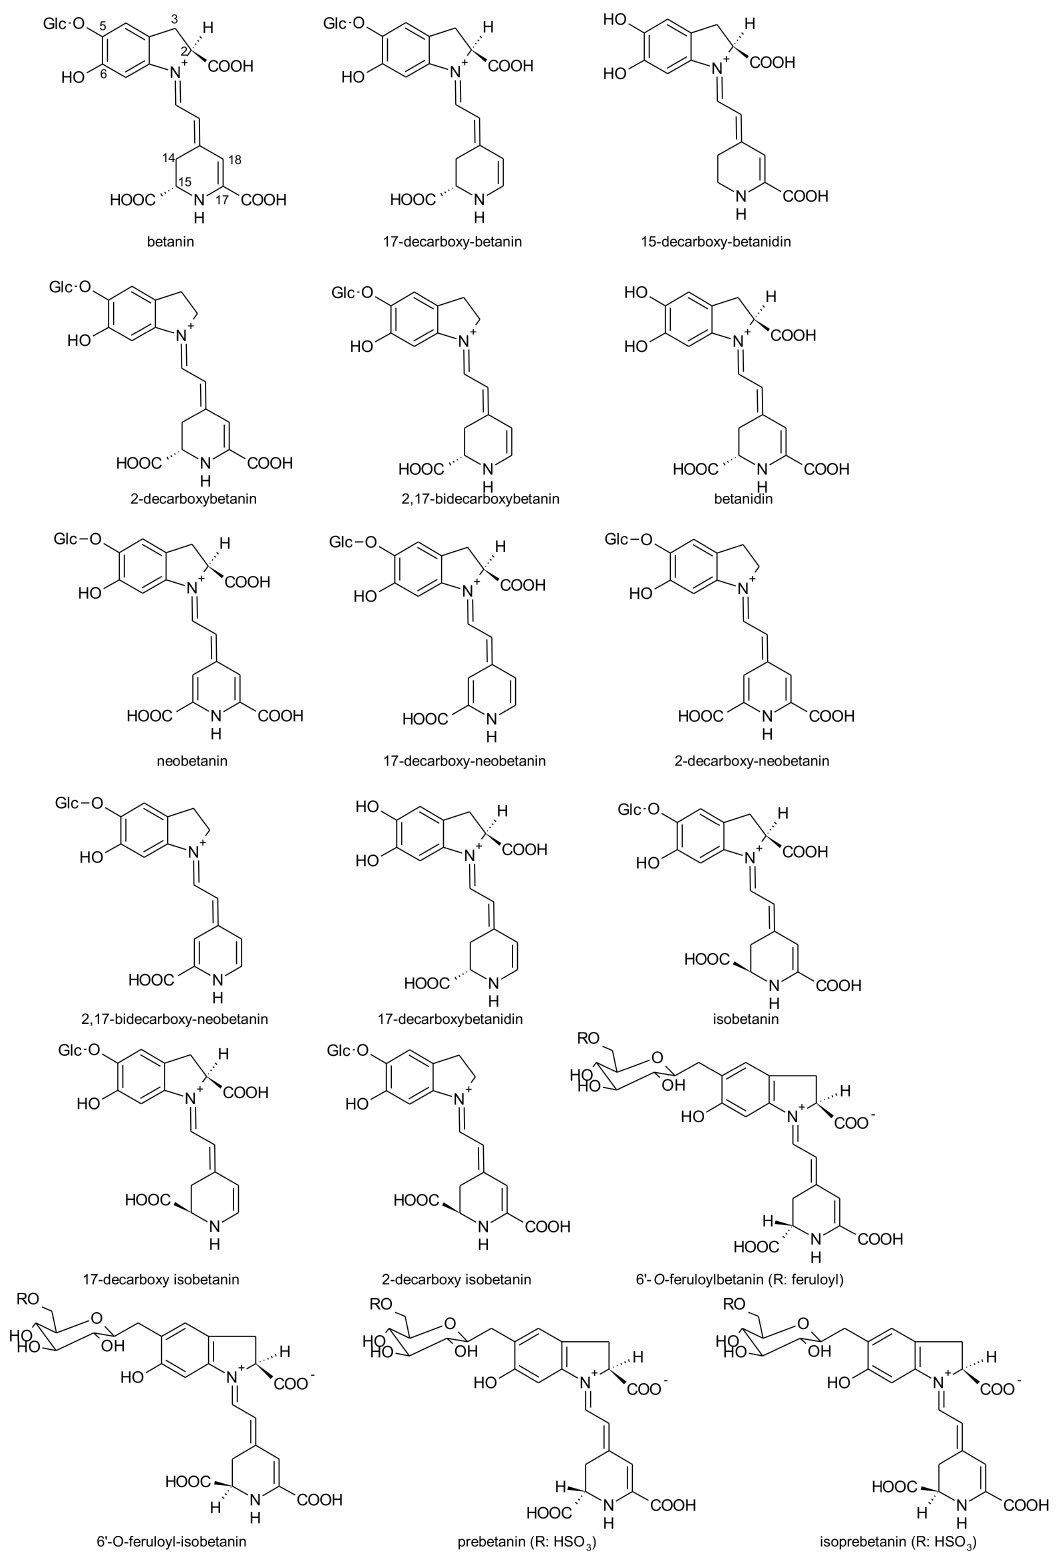
Figure 8. Betacyanins identified in the root parts of red